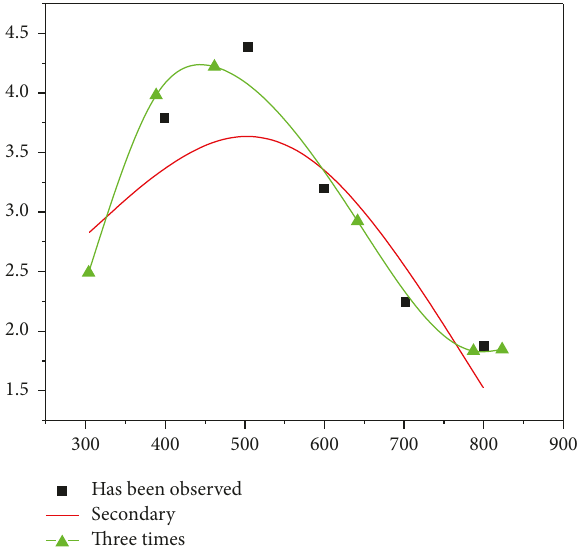
Figure 14: Fitting diagram of the curve